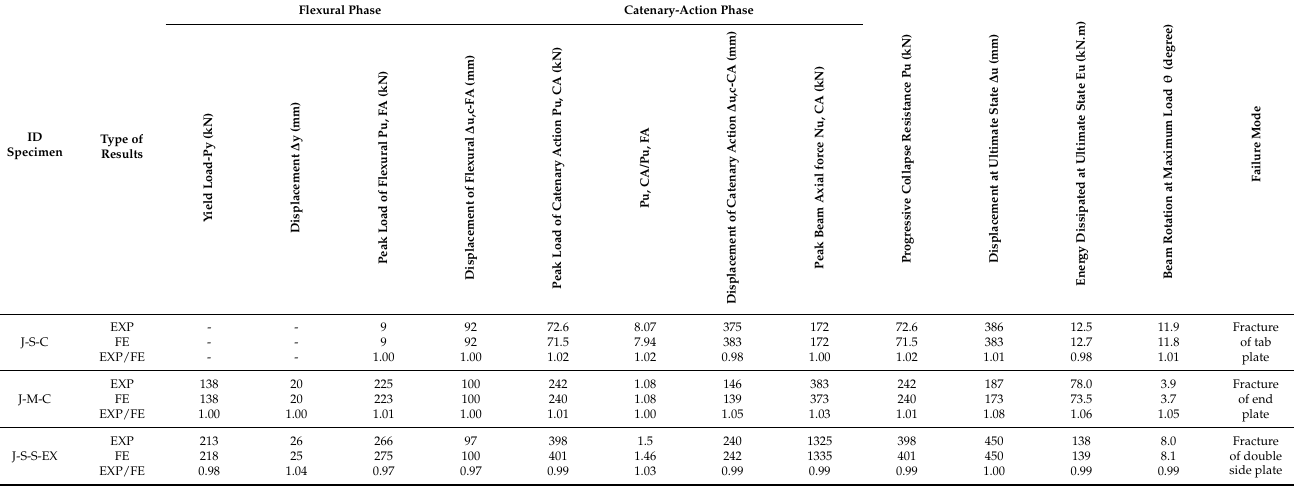
Table 2. Evaluating the force displacement response of experiments and finite elements [29].